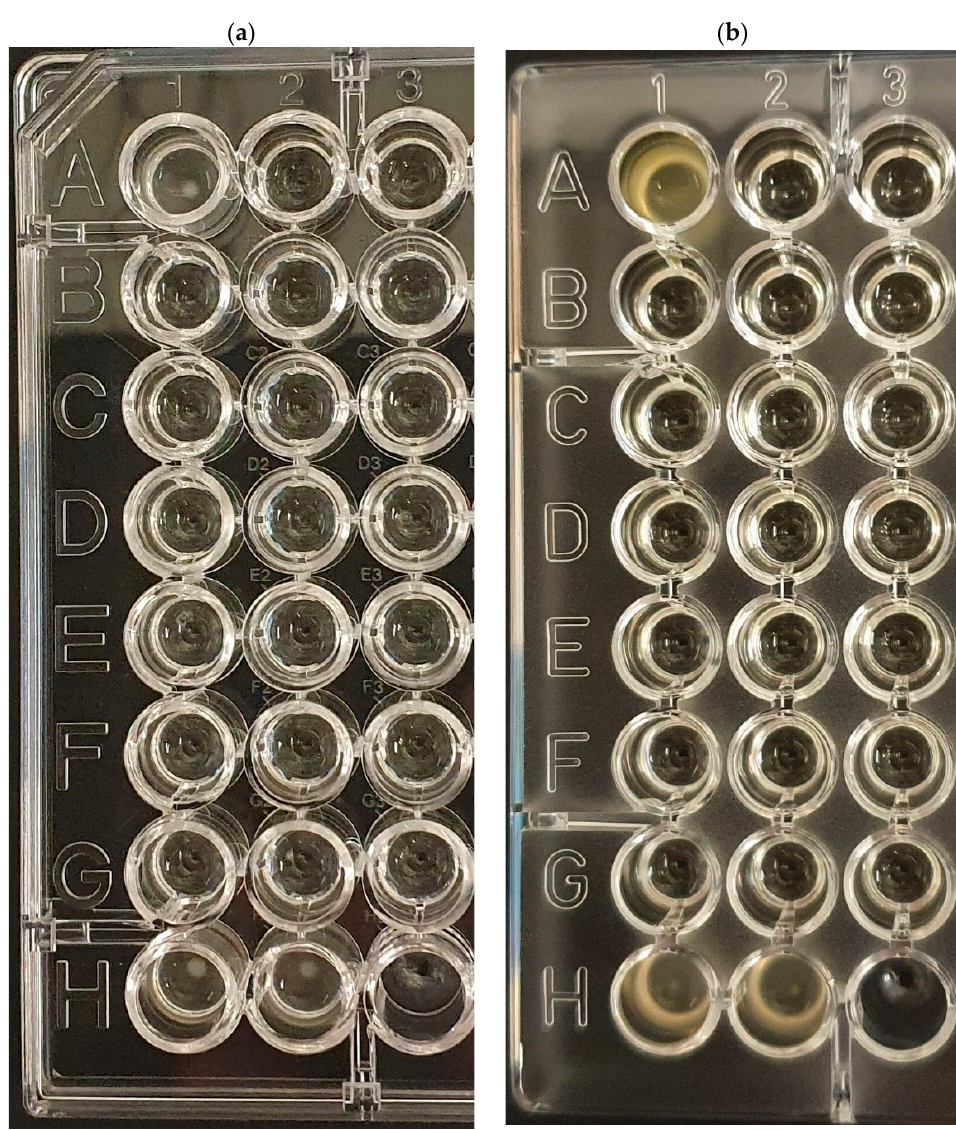
Figure 1. This figure shows part of a round ‐ bottom 96 ‐ well plate of the NAC concentrations in varying concentrations, positive and negative growth controls. Columns 1 A to G are the NAC concentrations with bacterial suspension added with increasing concentrations beginning from A1 comprising 0.156% to G1 comprising 10% NAC. H1 and H2 show the two positive growth controls and columns 2 and 3 A to G are two negative growth controls per NAC concentration. H3 is empty. ( a ) Shows a Staphylococcus pseudintermedius isolate, showing button formation indicating bacterial growth at A1, H1 and H2 (positive growth controls). The next higher concentrations of NAC (B1– G1) and the negative growth controls (A2 and 3 ‐ G2 and 3) show a clear fluid, and hence, no bacterial growth. ( b ) Shows a Pseudomonas aeruginosa isolate where bacterial growth can be detected as turbidity formation, shown in A1, H1 and H2 (positive growth controls). The next higher concentrations of NAC and the negative growth controls (A2 and 3 ‐ G2 and 3) show a clear fluid, and therefore, no bacterial growth.